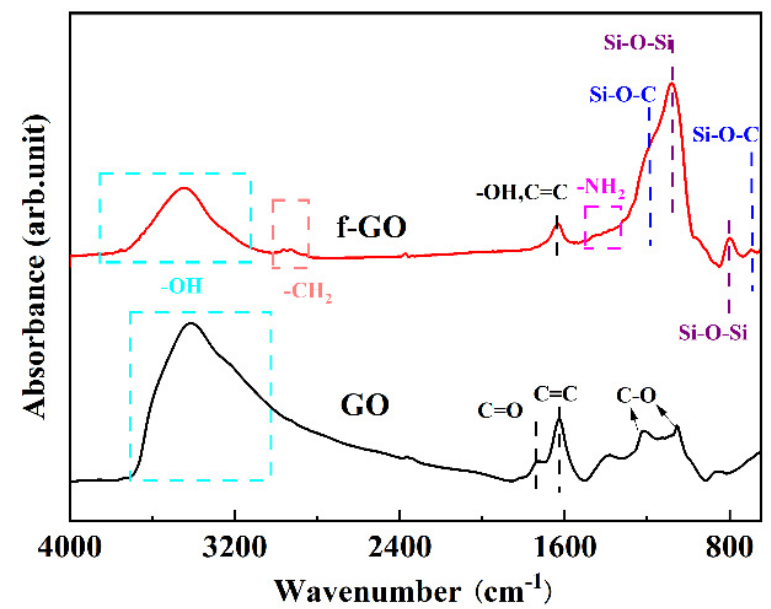
Figure 3. ATR-FTIR spectra of GO and f-GO nanosheets. As shown in Figure 4, XPS was used to analyze the surface chemical composition of GO before and after modification. As shown in Table 1, the element composition of GO is C and O (66.56 at%: 33.44 at%). For f-GO nanosheets, the elemental compositions are C, N, O and Si (32.38 at%: 1.9 at%: 39.57 at%: 26.15 at%). The presence of silicon and nitrogen indicates that silane was successfully presented on the sheet surface. The appropriate combination of Lorentz function and Gaussian function is used to distinguish the C 1s, N 1s, O 1s and Si 2p bonding states of f-GO nanosheets and GO. High-resolution energy spectrum analysis showed that C 1s of GO was mainly composed of C=C, C − O and C=O bonds located at 284.8, 286.9 and 288.3 eV before modification. After sol–gel modification, in addition to the above three peaks, three new peaks appeared at 283.6, 285.6 and 287.6 eV, which were, respectively, attributed to C − Si, C − O − Si and C − NH 2 [33]. The continuous presence of C=C, C − O and C=O peaks indicates that silane modification has no effect on the structure of GO. The appearance of C − Si and C − O − Si indicates that the hydroxyl group on the surface of GO is condensed with the hydroxyl group of silanes to form a covalent bond. However, for the peak splitting of O 1s, it was found that the O of GO was mainly hydroxyl oxygen at 532.8 eV [30]. After silane modification, a new peak belonging to C − O − Si appeared at 532.4 eV in the direction of low binding energy, which may be due to the transformation of C − O − H structure on graphene surface into C − O − Si structure during the condensation process of hydroxyl groups on silane and graphene surface. Since H is more electronegative than silicon, the bonding position of oxygen moves 0.4 eV toward the direction of low binding energy [34]. At the same time, Si − O − Si appeared in the oxygen peak, which also indicated that silicone appeared on the surface of graphene, which was consistent with the results of FTIR and SEM. At the same time, N element was also detected on the surface of the sample, which was mainly derived from aminopropyl trethoxy silane. However, for silicon, it mainly consists of three peaks, namely Si-O-C, Si(O) 2 and Si(O) 3 , located at 120.07, 103.8 and 104.7 Ev [35], respectively, which again indicates that successful grafting condensation of silane and graphene occurs, rather than simple mechanical